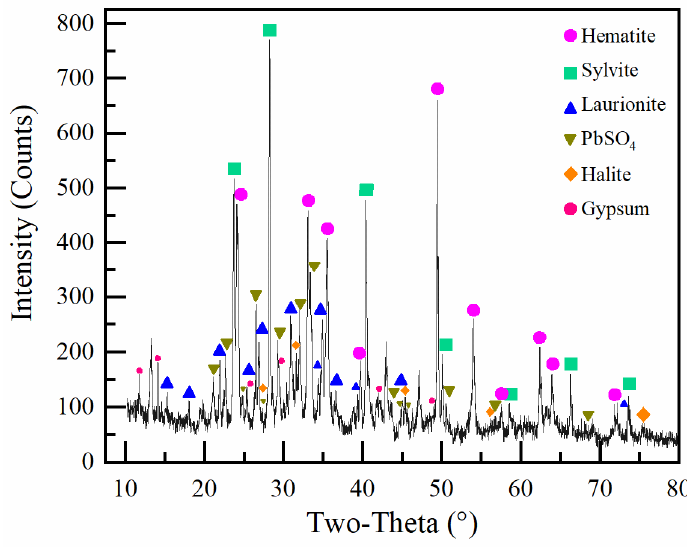
Figure 2. X-ray diffraction pattern of sintering dust.